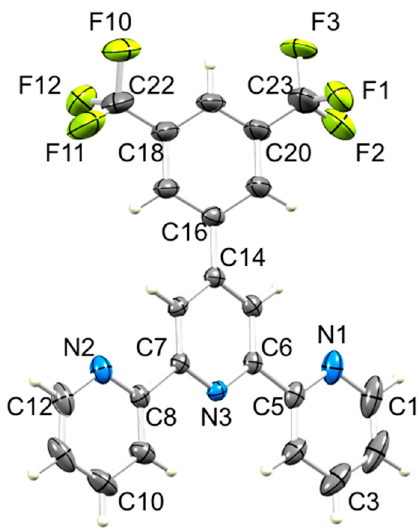
Figure 6. ORTEP-style diagram of molecule 5 with ellipsoids plotted at 40% probability level. Only the major occupancy F sites are shown (see text). Selected bond parameters: N1–C1 = 1.337(5), N1–C5 = 1.344(4), N2–C8 = 1.336(4), N2–C12 = 1.344(4), N3–C6 = 1.344(4), N3–C7 = 1.339(3), C23–F1 =